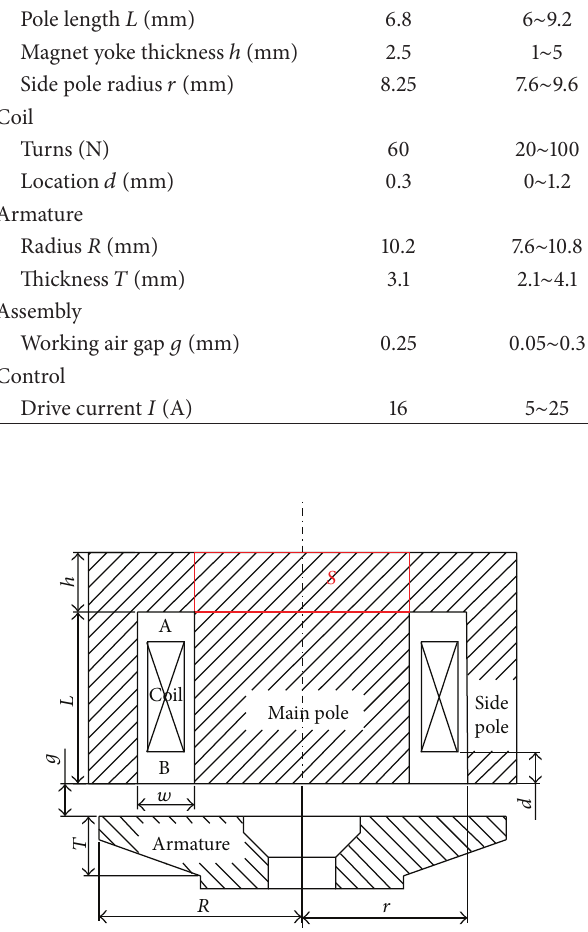
Figure 8: The schematic of electromagnet.